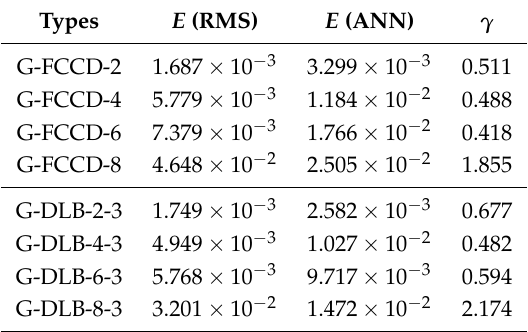
Table 3. The values of the normalized root-mean-square deviation of the surrogate models constructed from an RSM and ANN using the various datasets whose parameters are the wind turbine airfoil’s geometric variables. Here, the RSM-computed and ANN-computed surrogate models are constructed with exactly the same sample data.